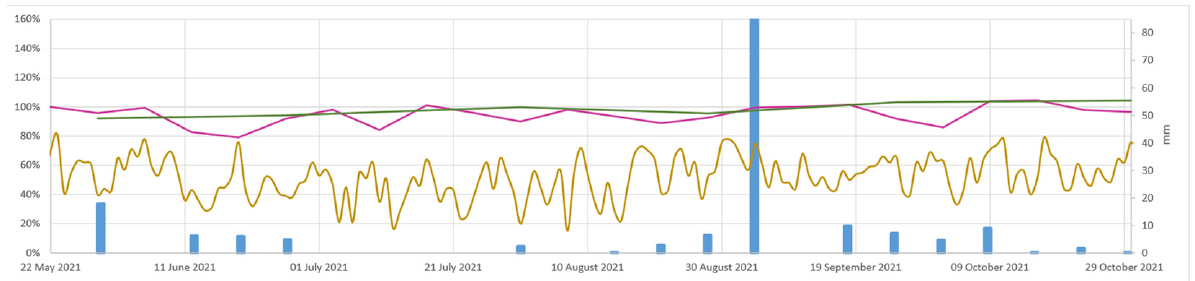
Figure 6. Moisture content (BBMC%, purple line and LFMC%, green line) vs. weekly-accumulated precipitation (blue column) and relative humidity (light brown line) during the 24 weeks study.